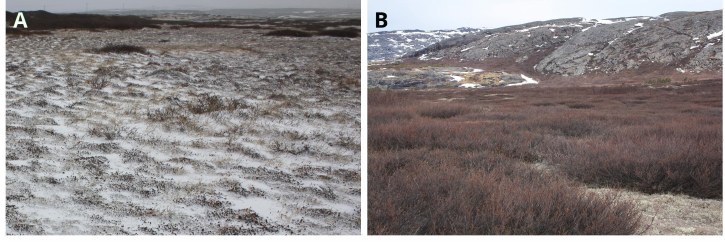
Figure 2. Photos of the study area taken in the coastal area ( A ) on 9 May 2010 and in the Tasiapik Valley ( B ) on 4 May 2010. Table 1. Classes used for sampling vegetation height (m) and vegetation coverage (%) during field